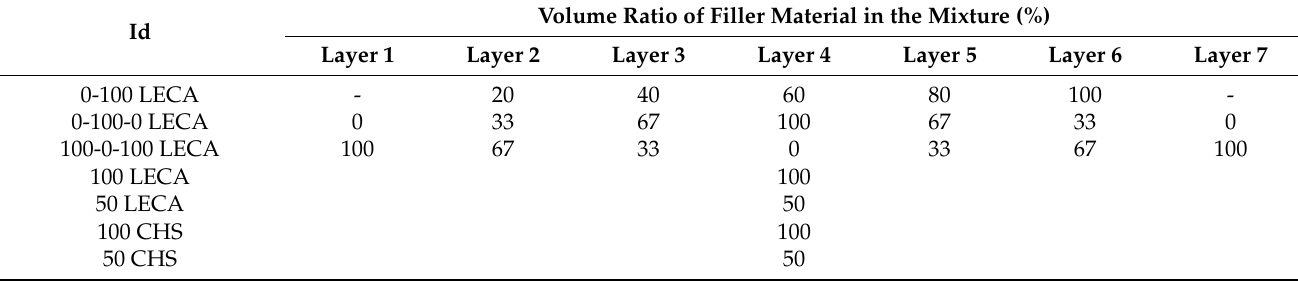
Table 2. Marking of test samples according to volume ratio of filler material in each